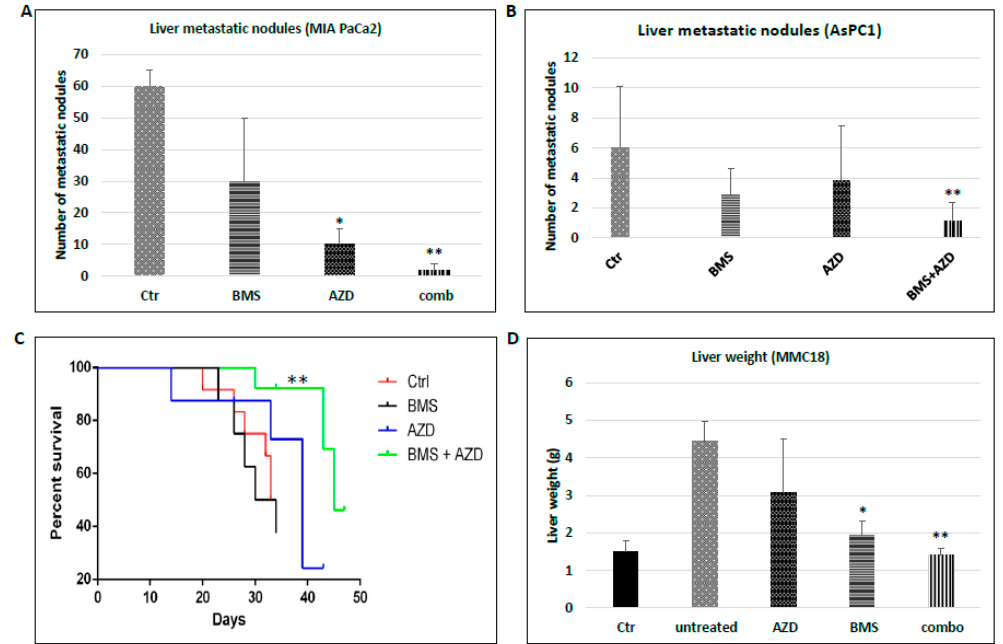
Figure 2. Simultaneous inhibition of MEK and Hh signaling in mouse models. ( A ) The number of metastatic nodules in the liver in MIA PaCa2-based orthotopic model in immune deficient NSG mice from four different treatments: (1) treated with smoothened inhibitor BMS833023; (2) treated with MEK inhibitor AZD6244; (3) the combination of AZD6244 and BMS833923; and (4) vehicle control (5 mice/group); ( B ) Effect of different treatments on the number of metastatic nodules in AsPC1-based mouse model (5 mice/group); ( C ) Kaplan-Meier survival curve for mice with different treatments in AsPC1-based mouse model, ** p < 0.05 was derived from Log-rank (Mantel-Cox) test; ( D ) Effect of different treatments on liver tissue weight, a measurement for liver metastasis, in MMC18-based model in immune-competent C57/B6 mice (5 mice/group). * p < 0.05 and ** p < 0.005 indicate significant or synergistic effect by BLISS independence analysis (see Statistical analyses for details).